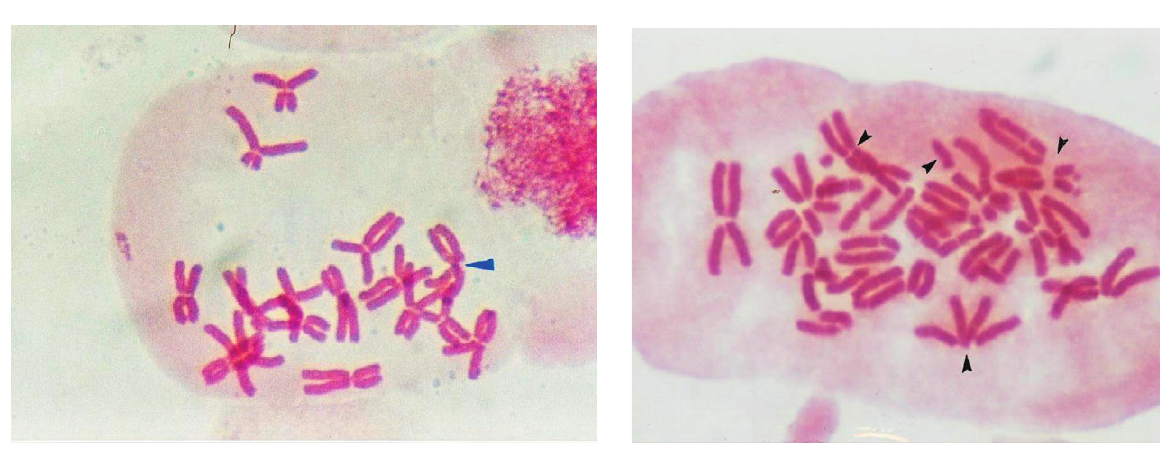
Figure 4. One chromosome is damaged. Figure 6. Whole chromosome set is damaged.